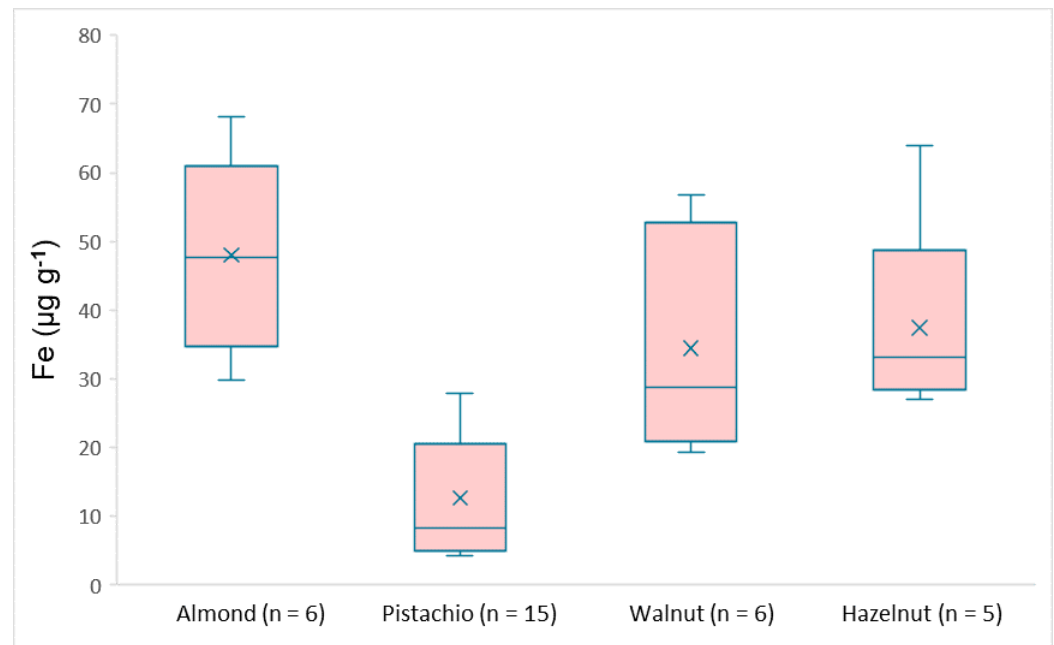
Figure 3. Box and Whisker plot for the concentrations of iron among different nut species.